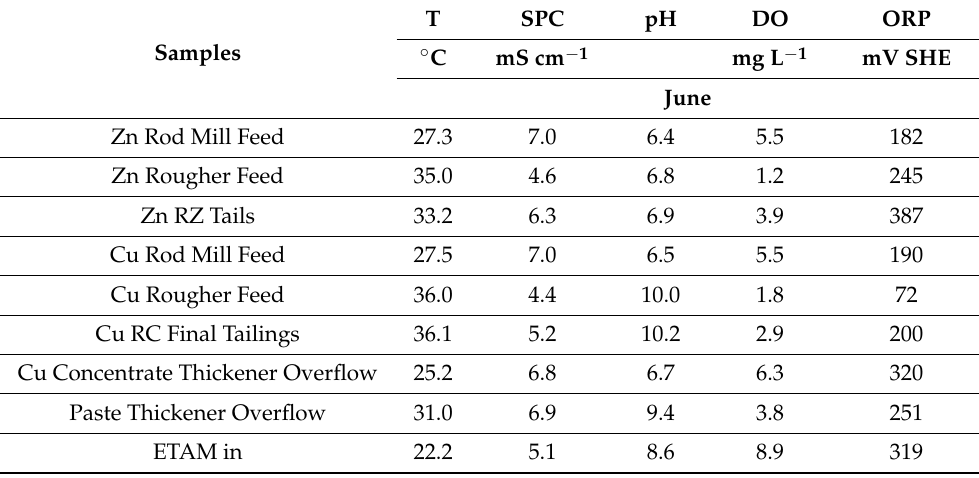
Table 1. The in situ measurements of the studied process samples in June and November samplings 2018; no samples were available from the TAI water. SPC, specific conductance; DO, dissolved oxygen; ORP, oxidation–reduction potential; N.A, not